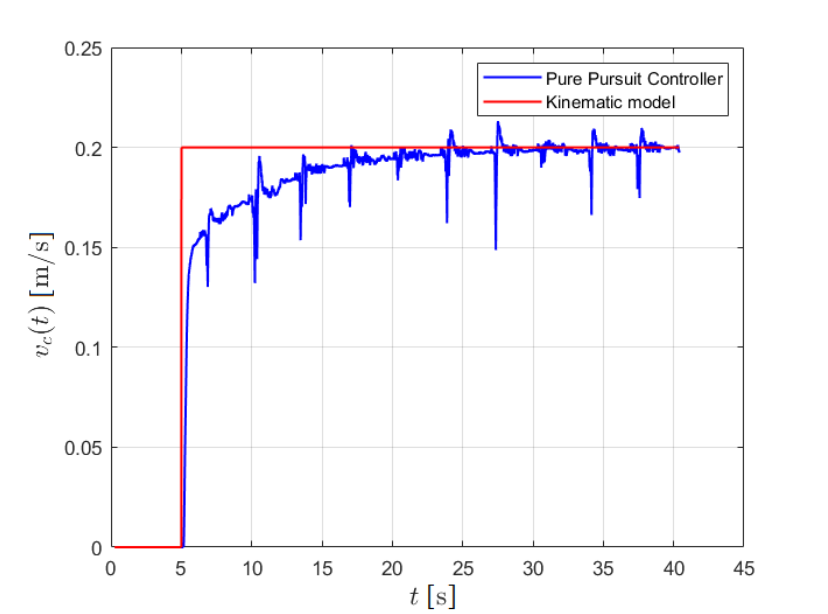
Figure 22. Linear velocity v c ( t ) of the